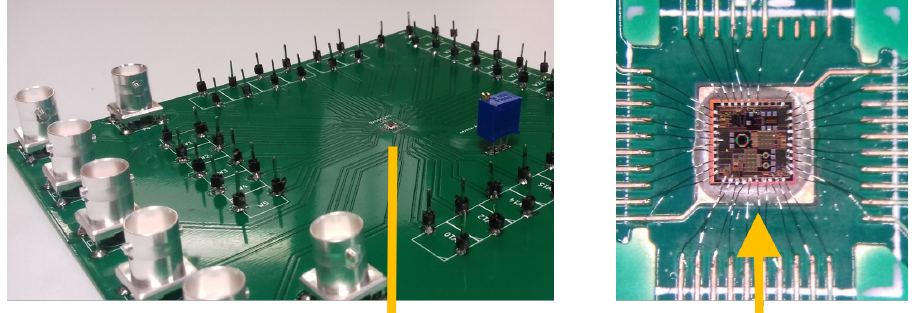
Figure 26. Implemented PCB for low-frequency